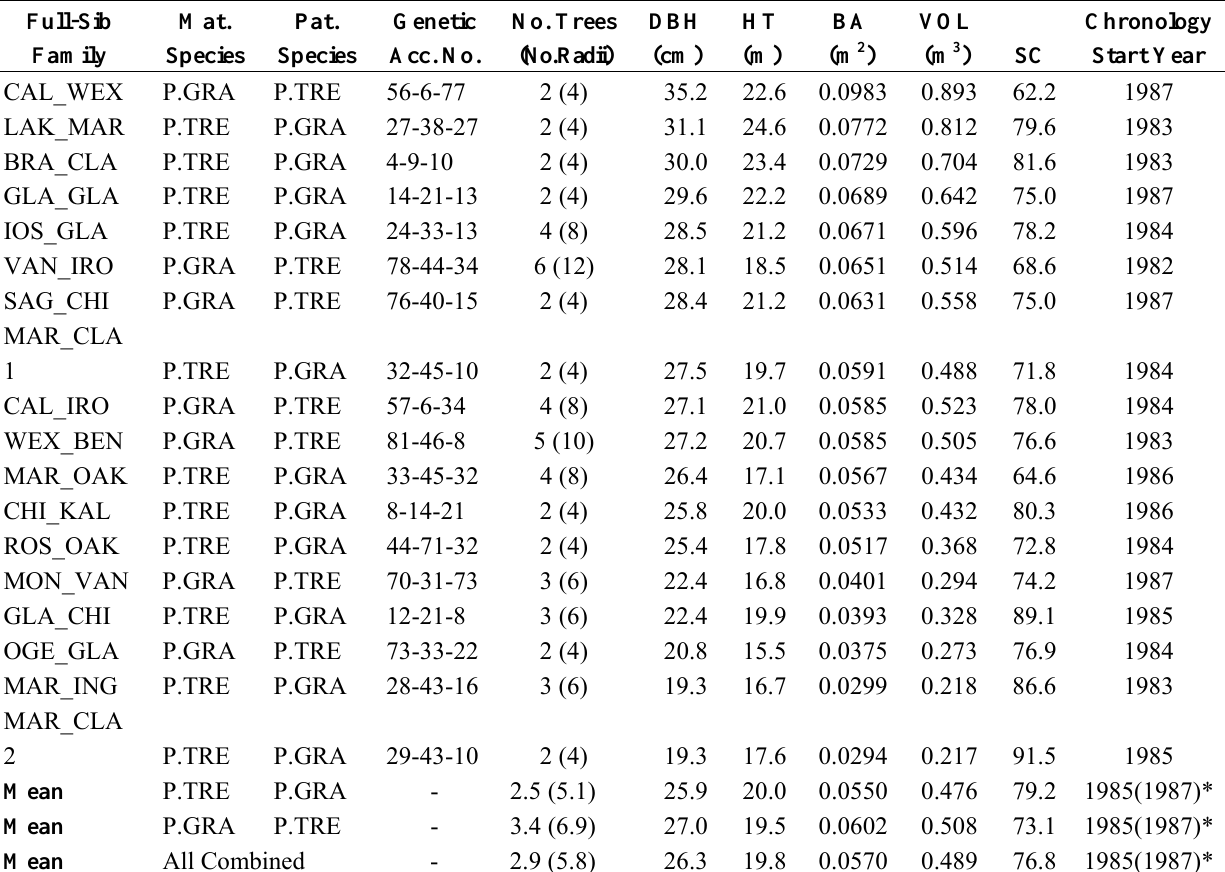
Table 2. Characteristics of full-sib families of hybrid poplar ( P. × smithii ) including county locations and species of maternal and paternal parents. Growth characteristics are cumulative values after 2009 growing season and are also averaged for families where maternal parent is P. grandidentata or P. tremuloides and the average for all families combined. Full-sib families are listed according to ranking (largest to smallest) of basal area values. The starting year of the annual tree-ring chronologies is also listed. Full-sib families, parental species, and growth variable abbreviations noted at end of